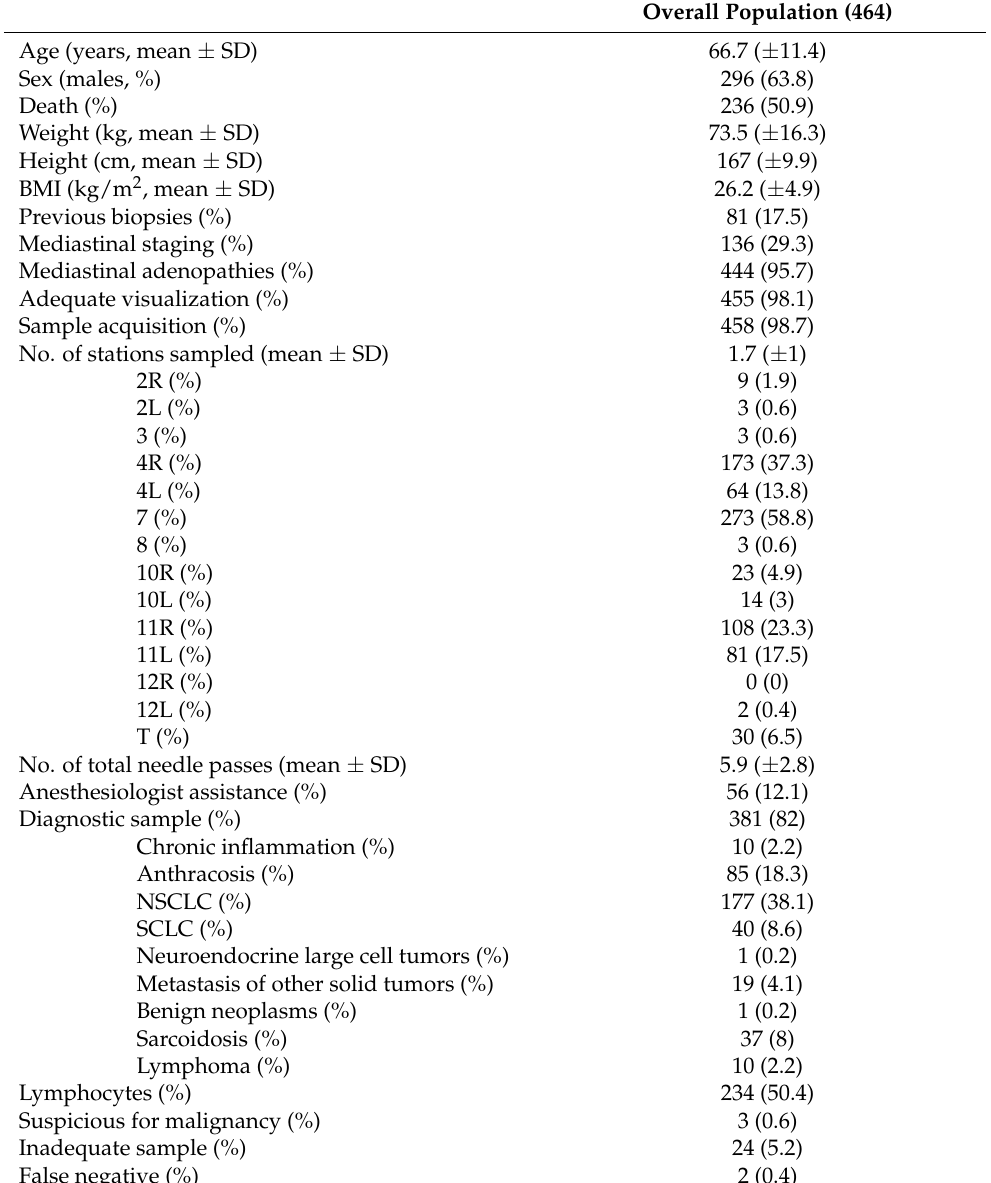
Table 2. Anagraphics, data regarding samples, and results in the overall population. SD, standard deviation; BMI, body mass index; NSCLC, non-small cell lung cancer; SCLC, small cell lung